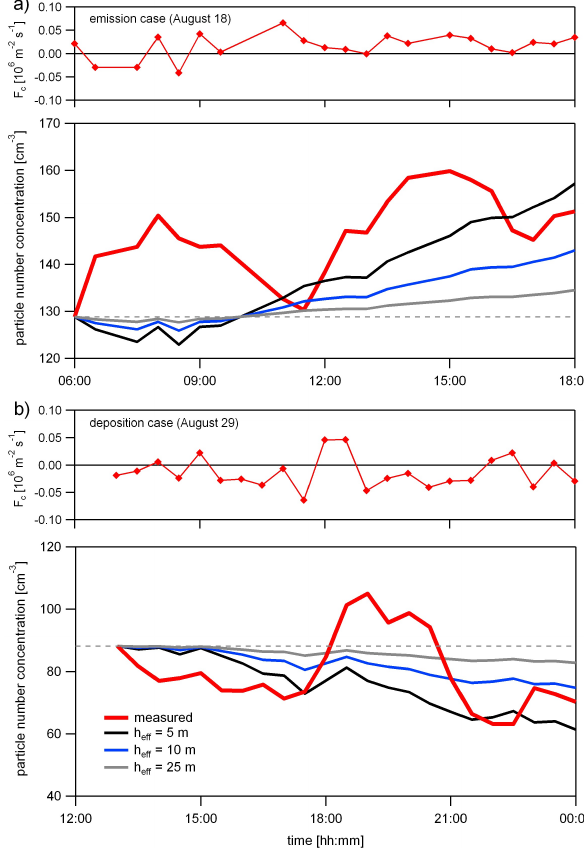
Fig. 7. Temporal change of the particle number concentration as measured and theoretically expected due to the measured turbu- lent aerosol flux F c , assuming three different scenarios of effec- tive mixing heights h eff , and a 25% area fraction of the open leads. (a) Emission dominated case on 18 August, and (b) deposition dom- inated case on 29